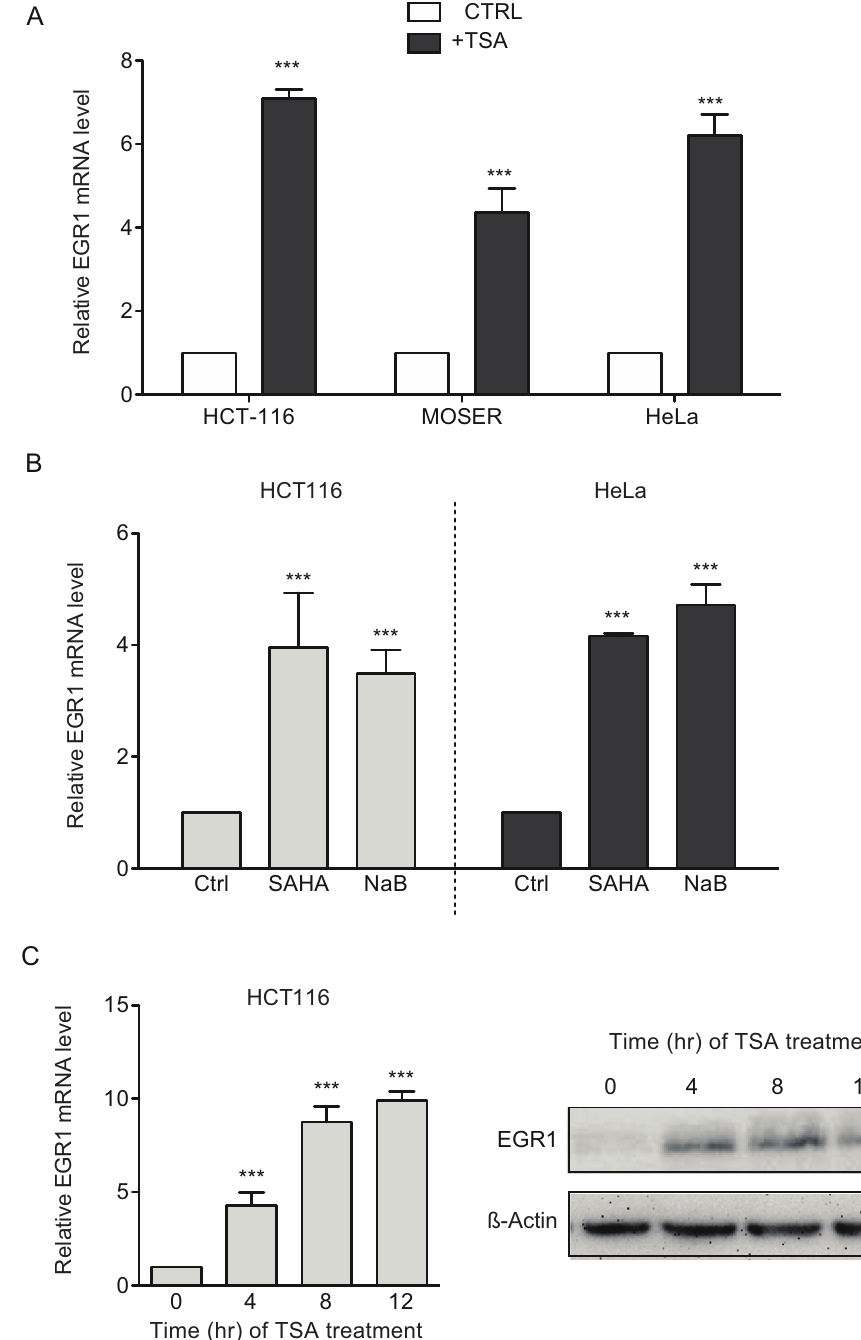
Figure 7. HDAC inhibitors induce EGR1 expression. ( A ) HCT116, Moser and HeLa cells were treated with 0.4 (cid:3)M of TSA for 12 h and then examined for changes in EGR1 mRNA levels by qPCR. ( B ) The expression of EGR1 in HCT116 and HeLa cells treated for 12 h with SAHA (5 (cid:3)M) or NaB (5 mM) by qPCR analysis. ( C ) Time course (0, 4, 8 and 12 h) of EGR1 expression in HCT116 cells treated with TSA (0.4 (cid:3)M). The expression of EGR1 was analyzed by qPCR ( left ) and western blot ( right ). qPCR was performed using GAPDH as a loading control. The data represent the mean of three independent experiments (± SD). *** p <